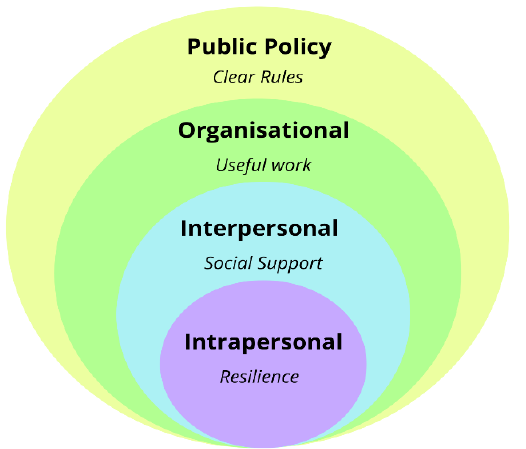
Figure 1. Four levels of socio-ecological factors that may influence the well-being of the self-employed during the pandemic. Adapted with permission from [37]. Copyright 1988 SAGE Publications